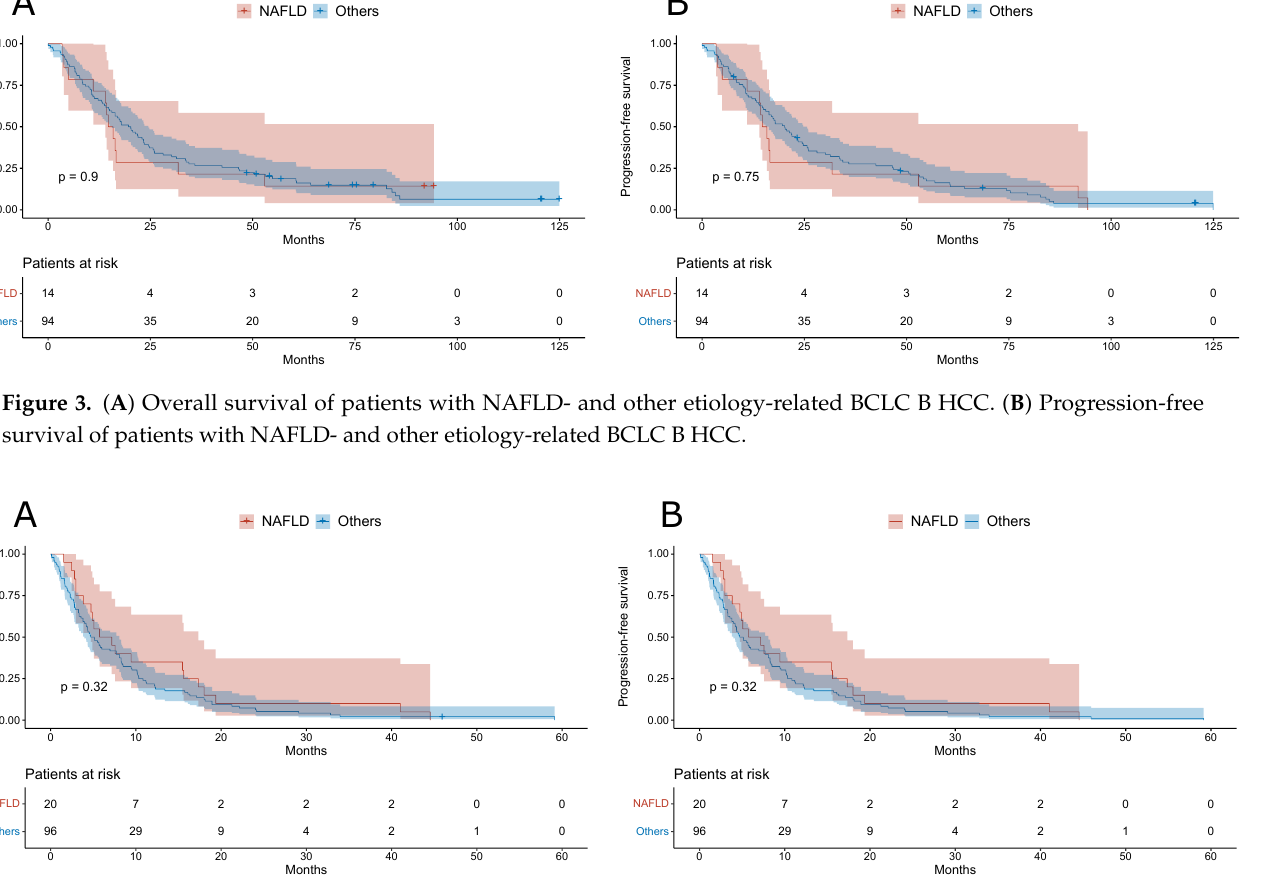
Figure 4. ( A ) Overall survival of patients with NAFLD- and other etiology-related BCLC C HCC. ( B ) Progression-free survival of patients with NAFLD- and other etiology-related BCLC C HCC.